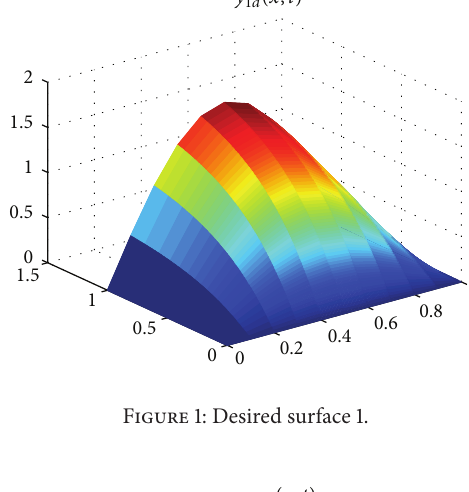
Figure 1: Desired surface 1.